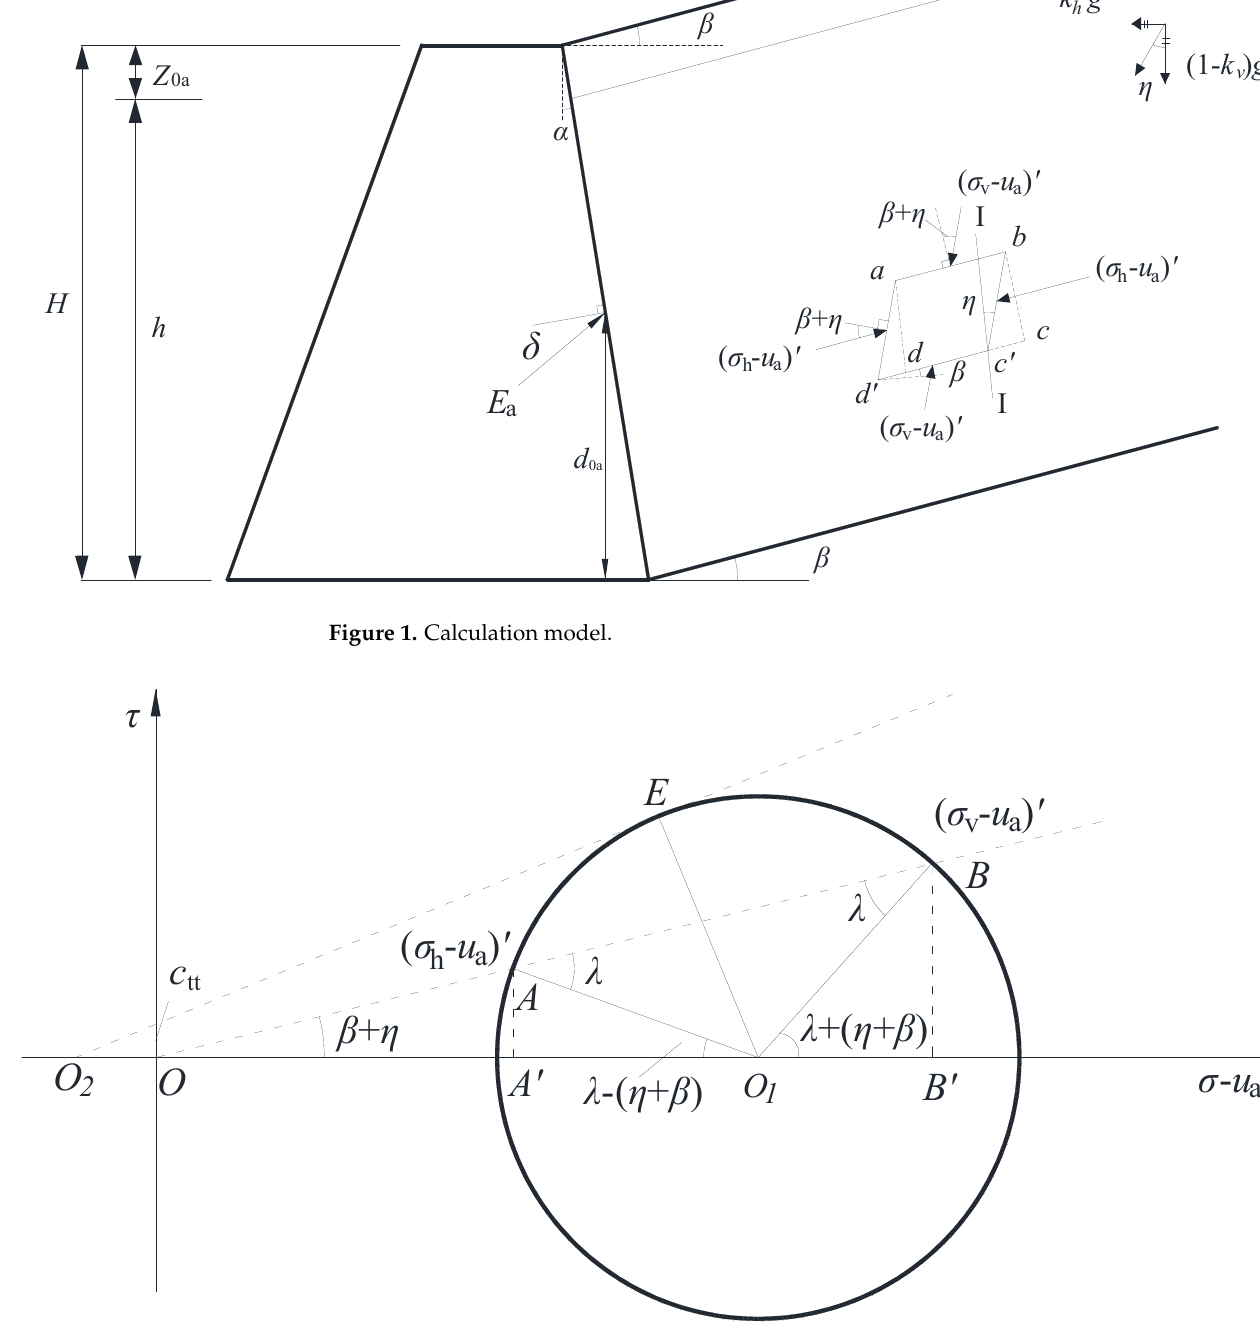
Figure 2. The Mohr stress circle of rhombic unit.